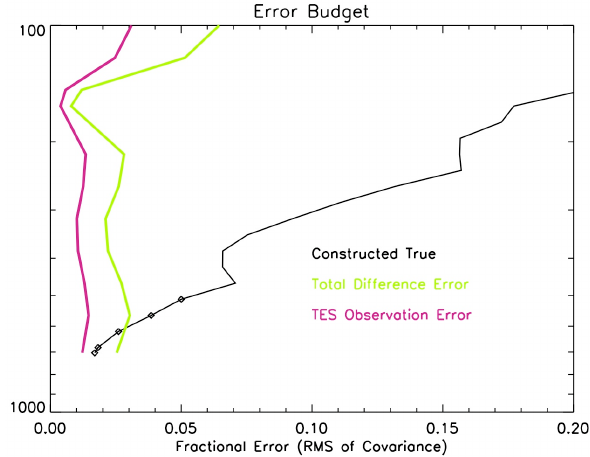
Fig. A8. Same as Fig. A3 but for 5 November 2008. Figure A8: Same as Figure A3 but for November 5 2008